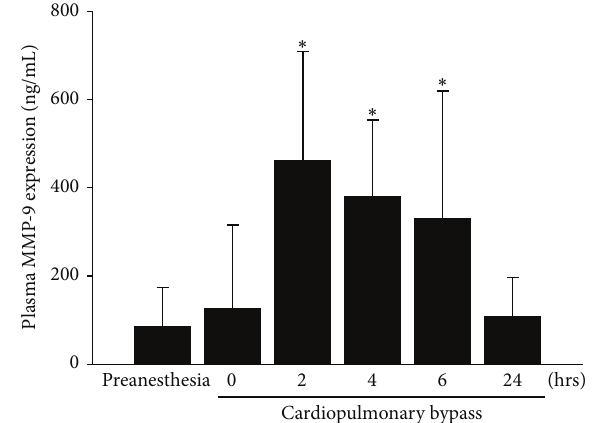
Figure 1: Plasma matrix metalloproteinase-9 concentrations increased significantly at 2–6 hours after beginning cardiopulmo- nary bypass ( 𝑛 = 30 ), as compared with the preanesthesia level (all 𝑃 < 0.001 ). The level returned closely to the preanesthesia level at 24 hours ( 𝑃 = 0.23